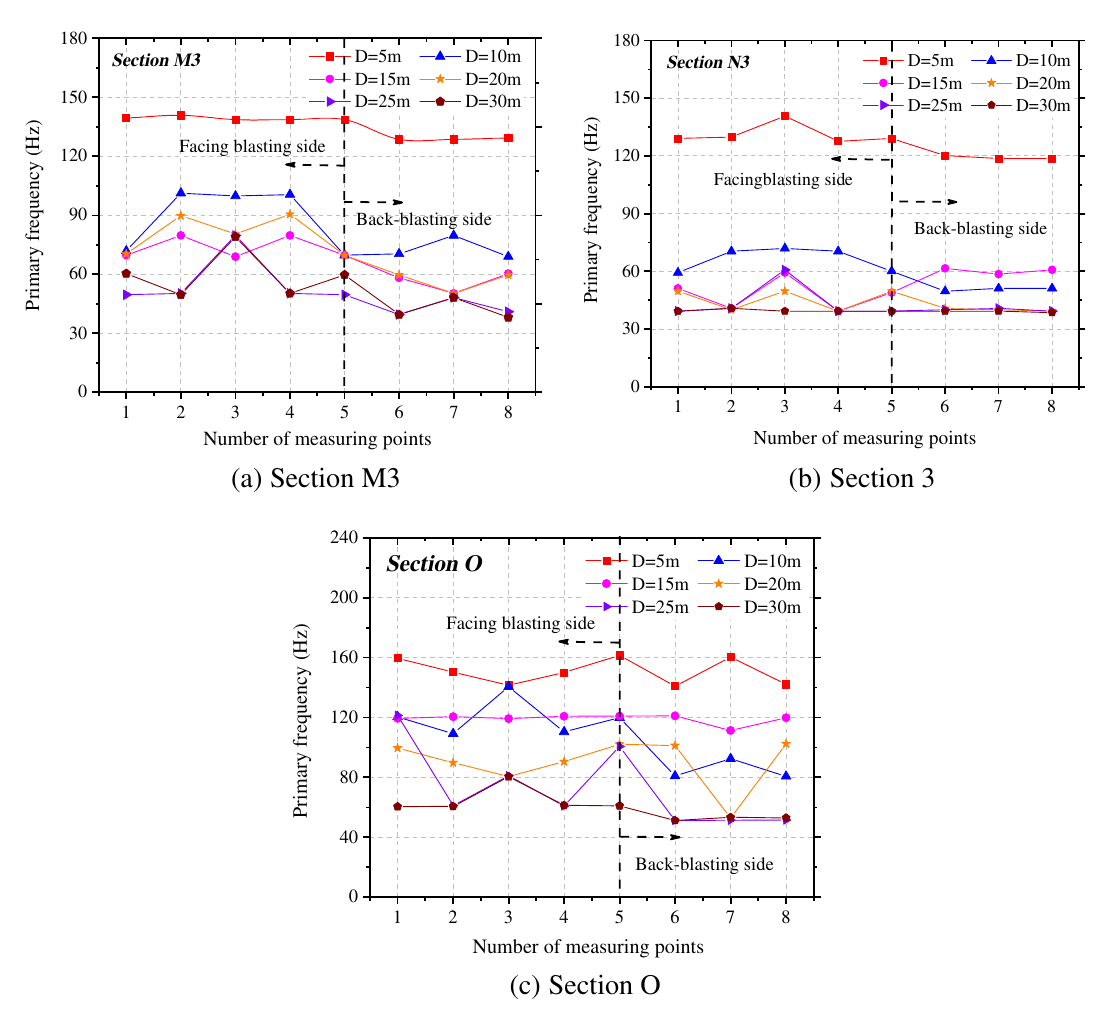
Figure 14. Primary frequency of the adjacent tunnel under different tunnel